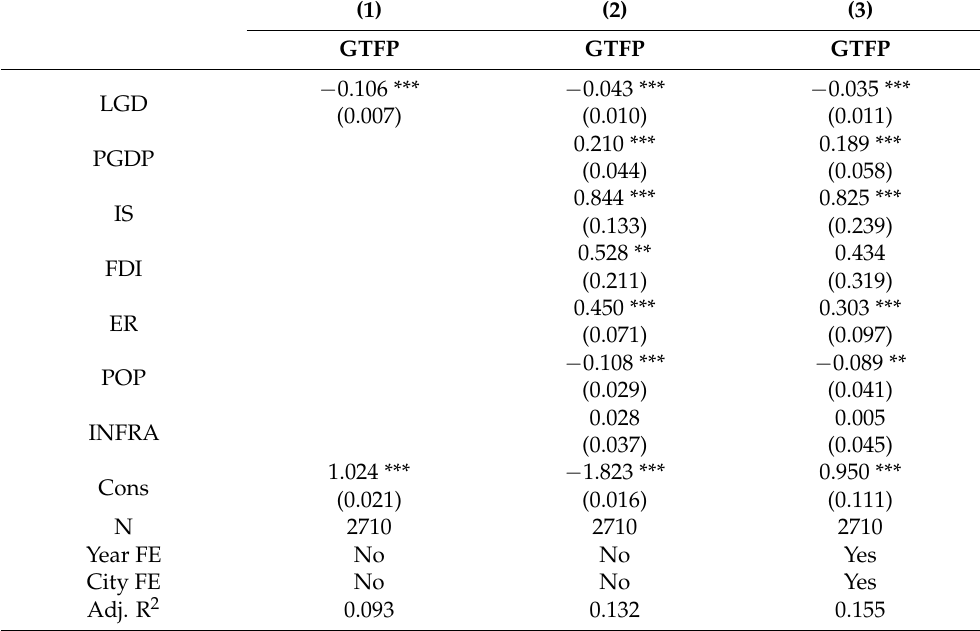
Table 3. Effect of LGD on